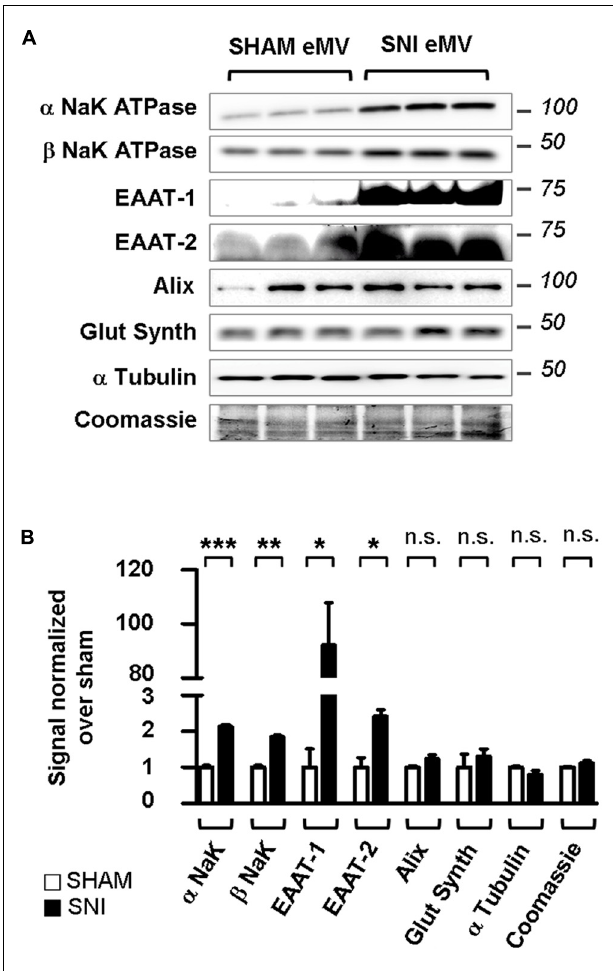
FIGURE 9 | Spared nerve injury spinal explants are enriched in EAAT-1 and EAAT-2. (A) Western blots illustrating the increased NaK ATPase, EAAT-1, EAAT-2 but not glutamine synthetase, Alix, α tubulin or total protein content (Coomassie) contents in eMV from SNI rats as compared to counterparts from sham animals. (B) Quantification of western blot signals confirming the statistical increases observed in (A) . Given as mean ± SEM. * p < 0.05; ** p < 0.01; *** p < 0.001; n.s., non significant. Student’s t -test withWelch correction for unequal variances, sham vs. SNI ( n = 3 explants from different animals per